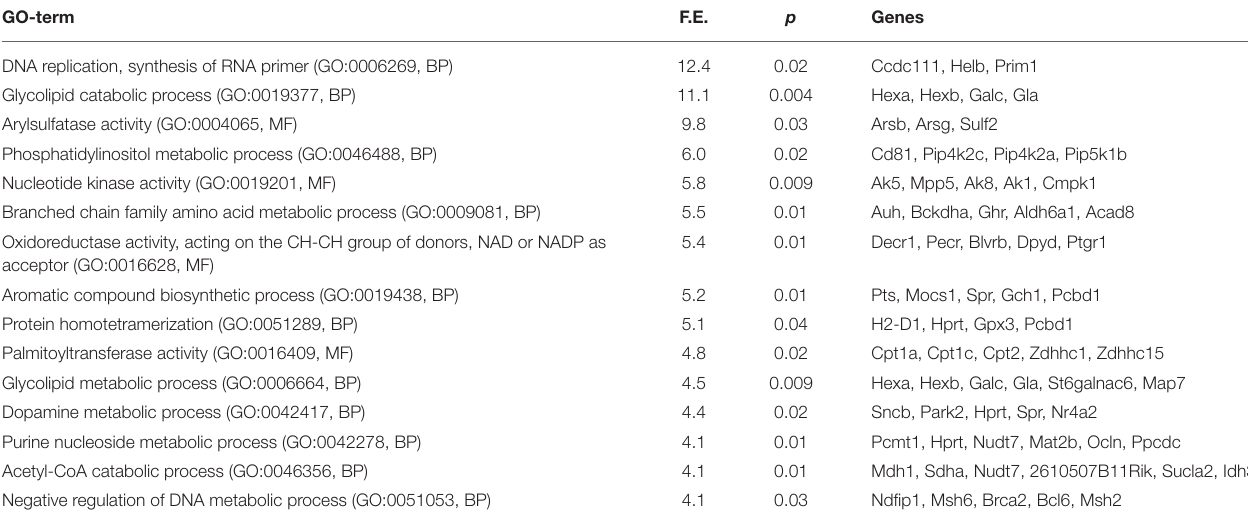
TABLE 5 | Most significantly enriched GO-terms from the genes down-regulated during maturation of the SCG neurons. GO-term F.E. p Genes